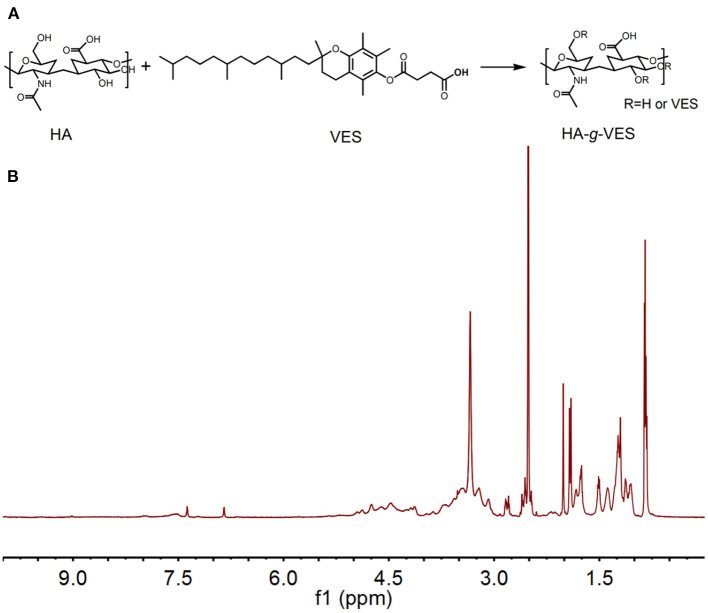
(A) Synthesis route of HA-VES (A) and (B)
1H NMR spectrum.